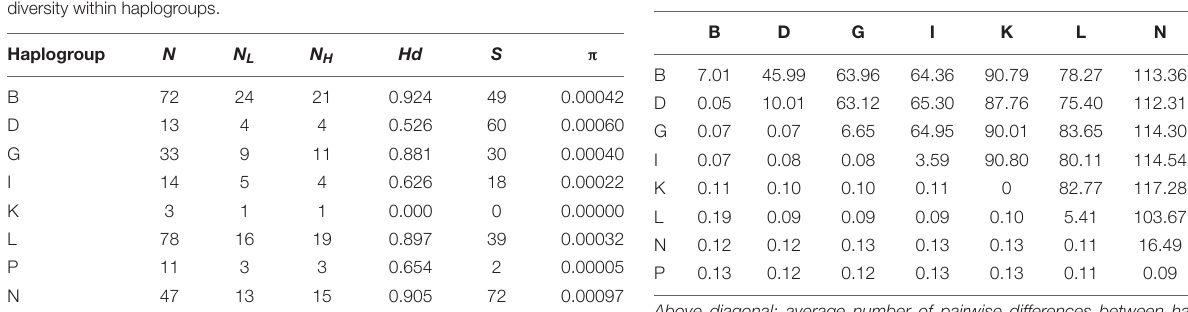
pairwise differences between and within haplogroups.